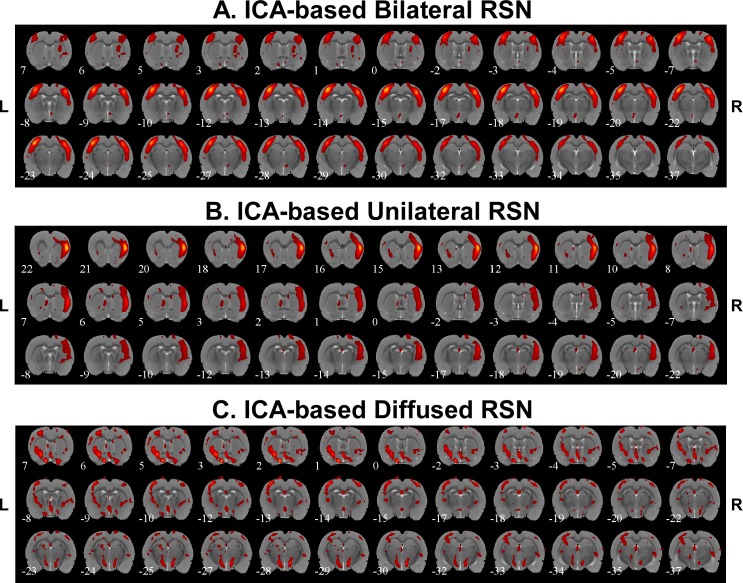
Independent component analysis (ICA)-based resting state networks.A) Example of bilateral connectivity (Rat 4). B) Example of unilateral connectivity (Rat 2). C) Example of diffused connectivity (Rat 6). R = right; L = left.